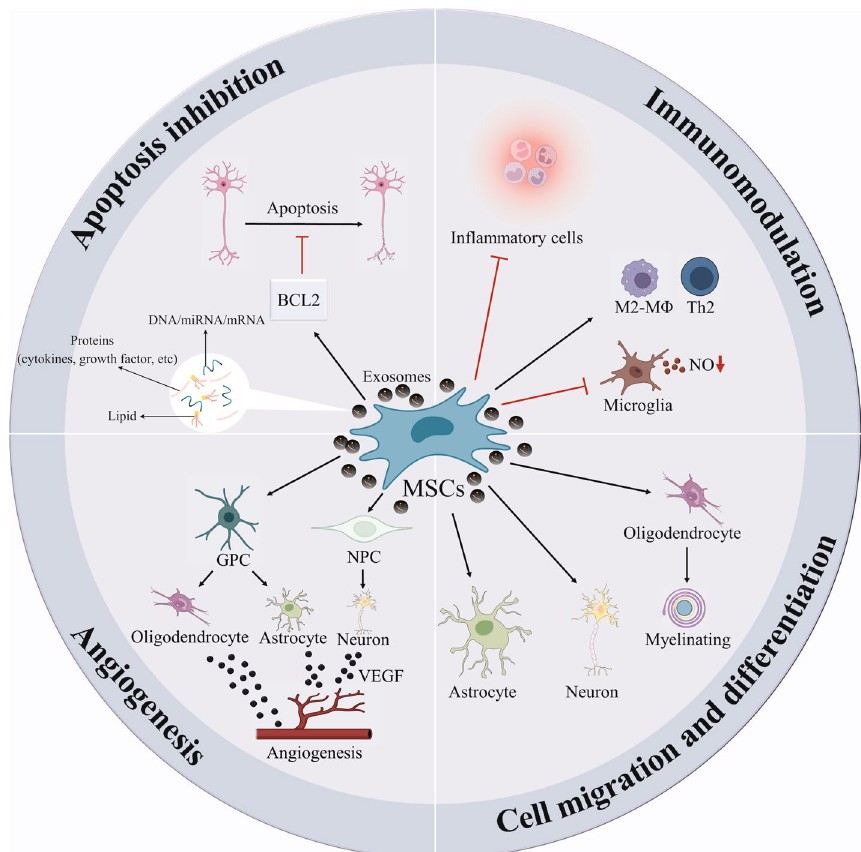
Fig. 1 Underlying mechanisms contributing to mesenchymal stromal cell (MSC)-mediated neuroprotection and neurogenesis in chronic neurodegenerative conditions. GPCs, glial progenitor cells; NPCs, neural progenitor cells; VEGF, vascular endothelial growth factor; M2-M ɸ , M2 macrophages; Th2, T-helper 2; NO, nitric oxide; BCL2, B-cell lymphoma